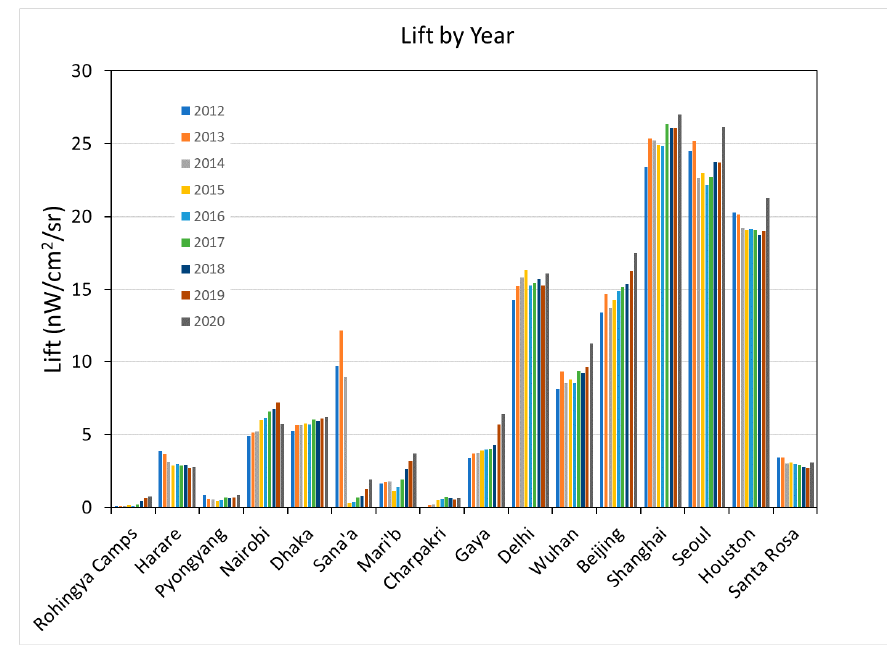
Figure 31. Picket-fence chart of the mean lift for each of the test sites by year.